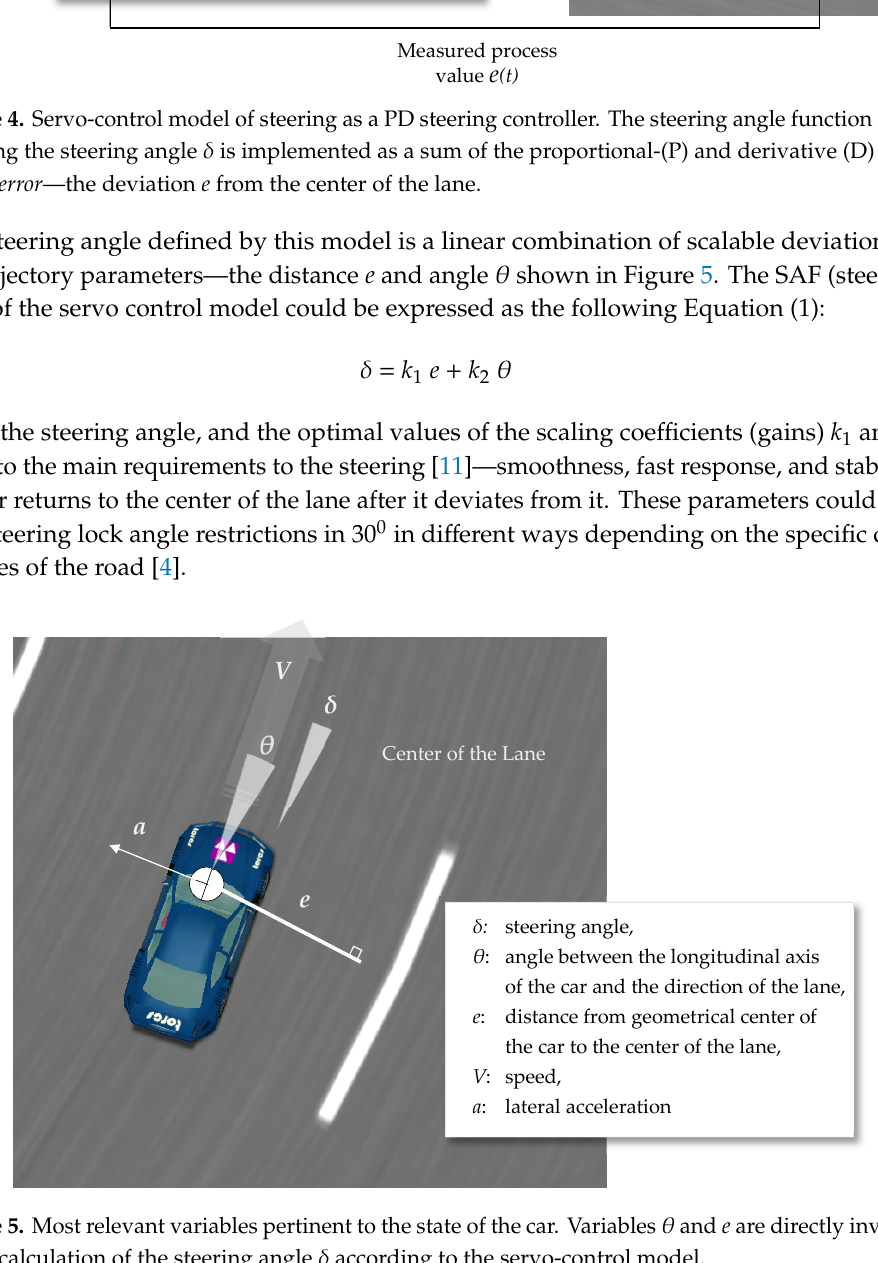
Figure 5. Most relevant variables pertinent to the state of the car. Variables θ and e are directly involved in the calculation of the steering angle δ according to the servo-control model.